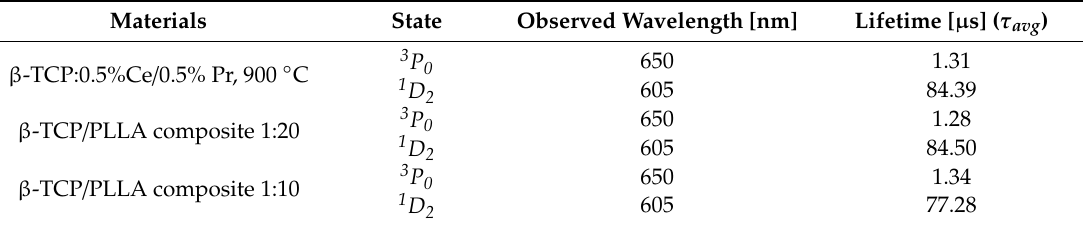
Table 1. Calculated lifetimes of β -TCP co-doped with Ce 3+ and Pr 3+ ions PLLA with β -Ca 3 (PO 4 ) 2 composite with phosphate:polymer 1:10 ratio and PLLA with β -TCP composite with phosphate:polymer 1:20 ratio. Delays from the state 3 P 0 were observed at 650 nm and delays from the state 1 D 2 were observed at 605 nm.